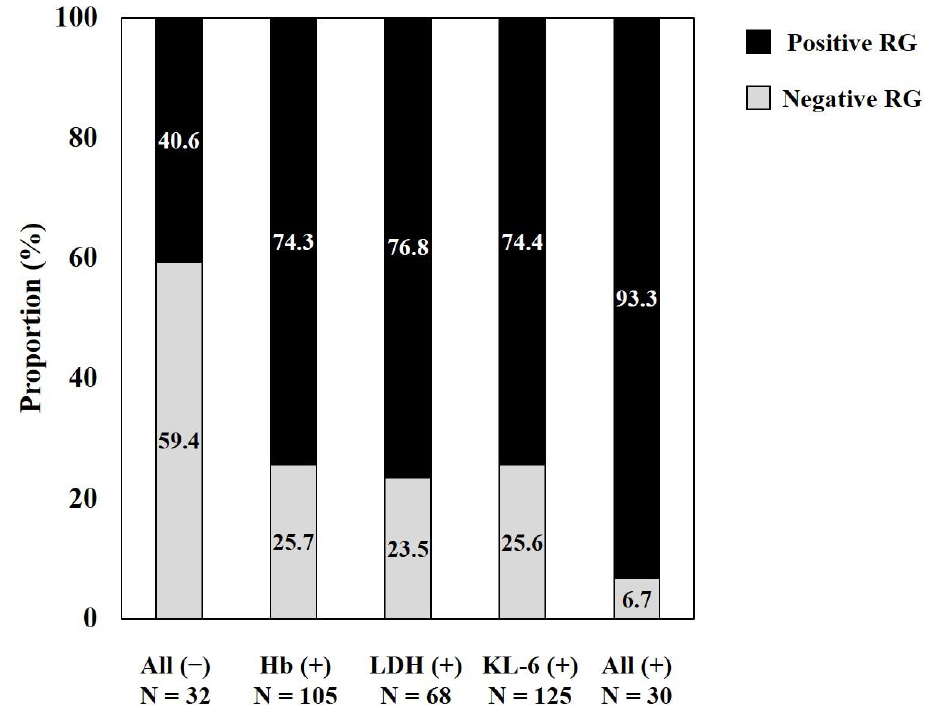
Figure 3. Proportion of RG-positive group according to the dichotomized Hb, LDH, or KL-6 group. All ( − ) or all (+) indicates a group in which all biomarkers of Hb, LDH, and KL-6 have a value less than or greater than each cut-off value. Hb (+), LDH (+), or KL-6 (+) indicates a group showing a value greater than each cut-off of Hb, LDH, or KL-6 alone. The proportion of RG positive group was 74.3%, 76.8%, and 74.4% in Hb (+), LDH (+), and KL-6 (+) patients, respectively. The proportion of RG positive group increased significantly up to 93.3% when Hb, LDH, and KL-6 were all positive ( p = 0.026 vs. Hb; p = 0.052 vs. LDH; p = 0.025 vs. KL-6). Abbreviations: Hb, hemoglobin; LDH, lactate dehydrogenase; KL-6, krebs von den lungen-6; RG, reticulin grade.